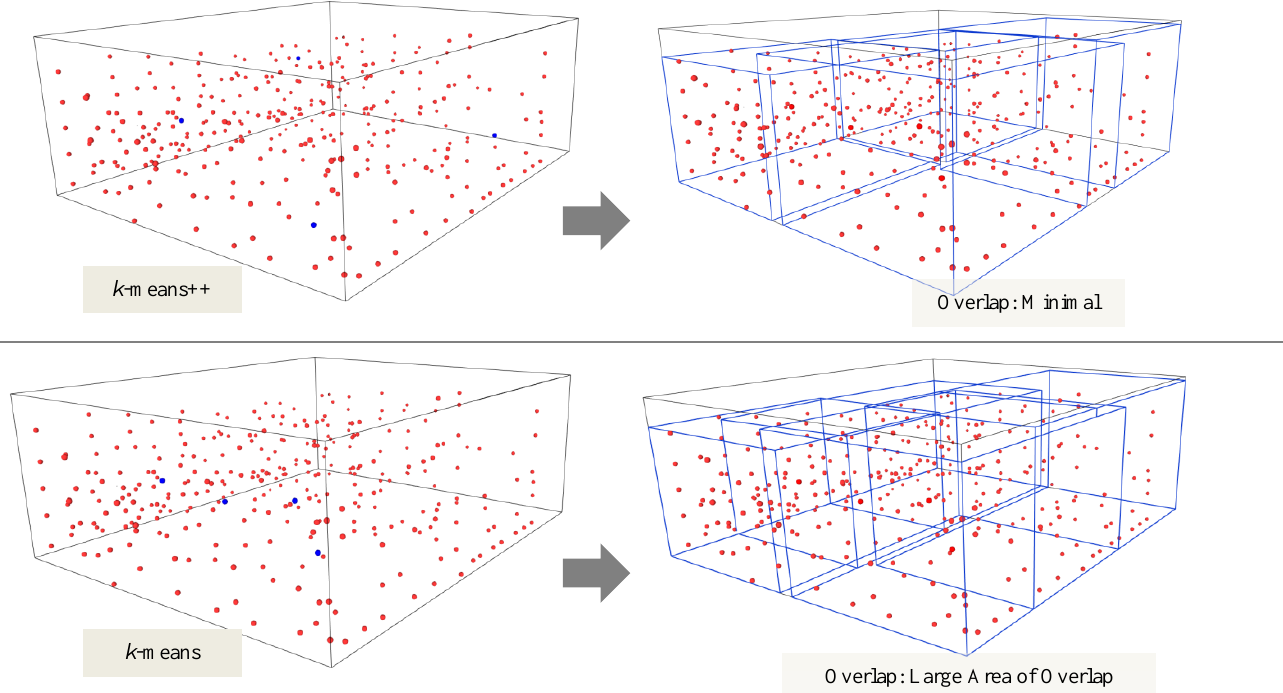
Figure 2. Comparison of initial cluster center by k -means and k